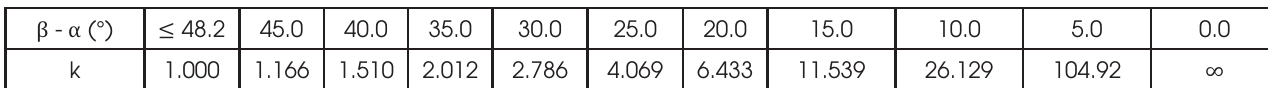
k factor for different skew angles